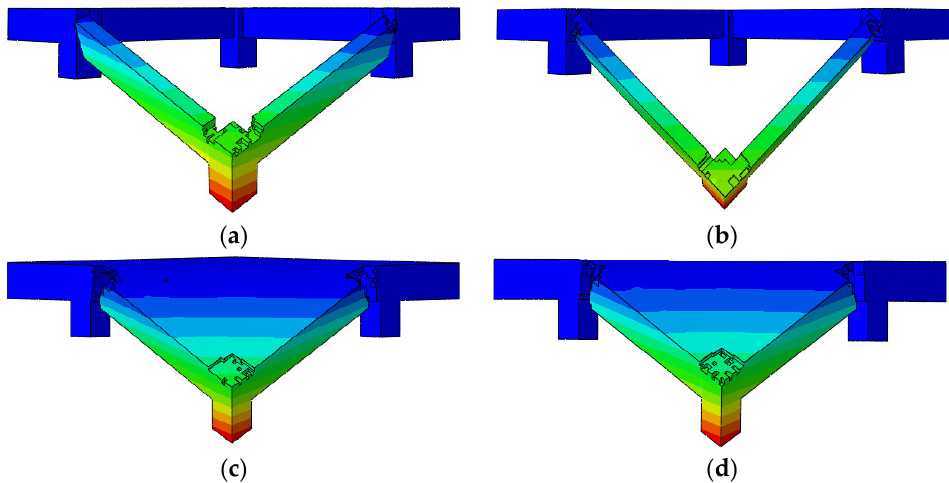
Figure 24. Torsion effects on in scenario “B” specimens: ( a ) NC-COR; ( b ) RuC-COR; ( c ) NC-COR-Slab; and ( d ) RuC-COR-Slab. Table 10. Results of FE modelling for all specimens.